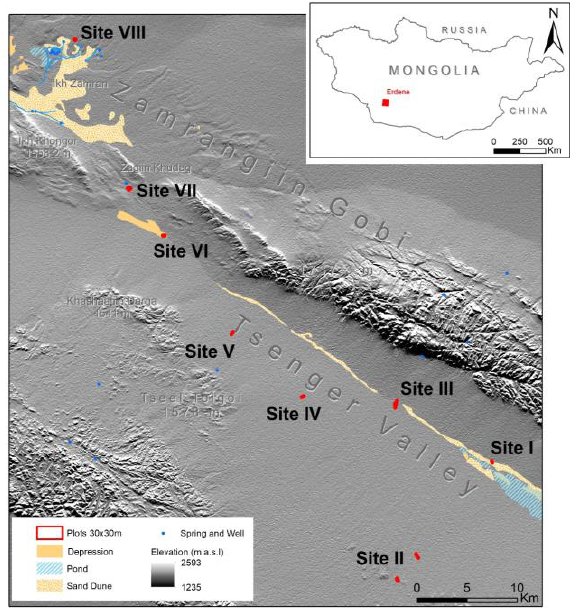
Figure 1. The study site in Gobi-Altai province, Trans-Altai as south western part of